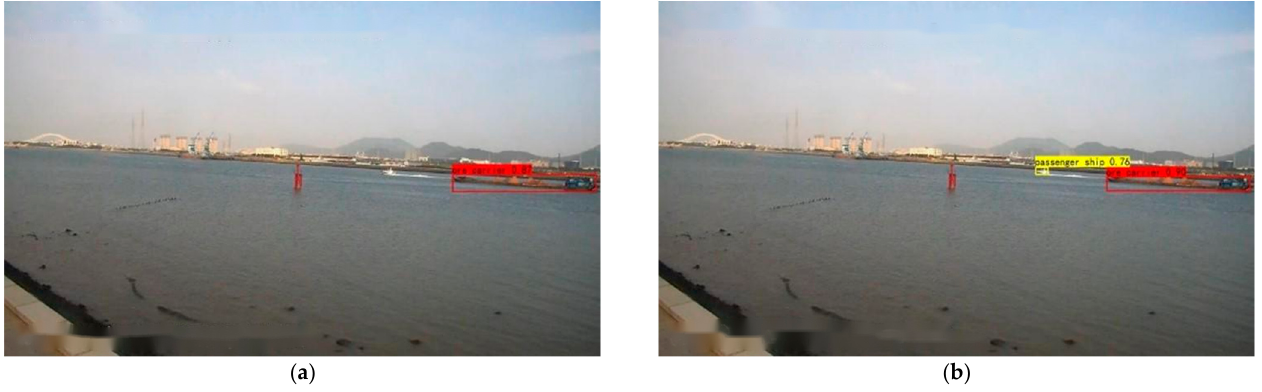
Figure 13. Comparison of the detection effect of small targets around large targets. ( a ) YOLOX_s detection results; ( b ) CBAM-YOLOX detection results.